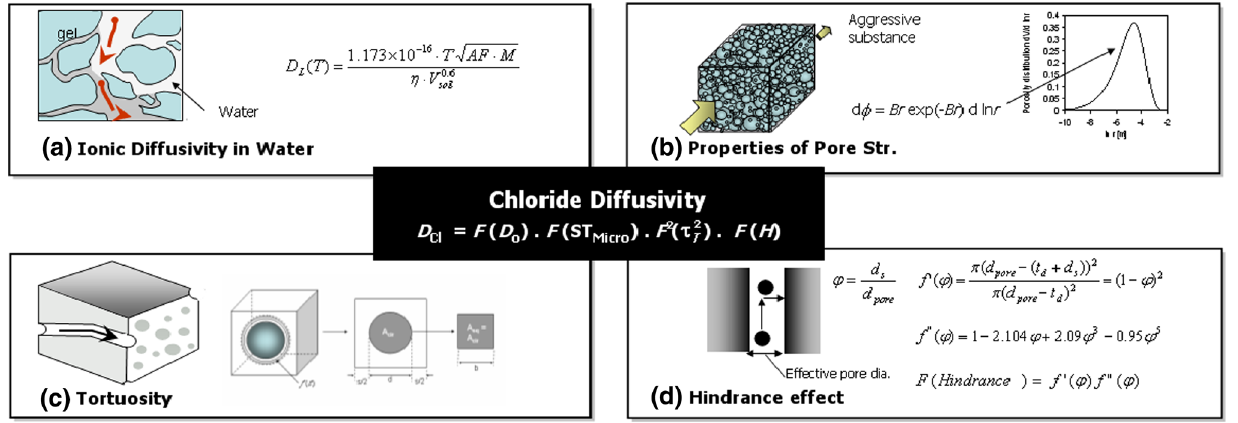
Fig. 1 Formation of chloride diffusivity to consider various affecting parameters (Yoon